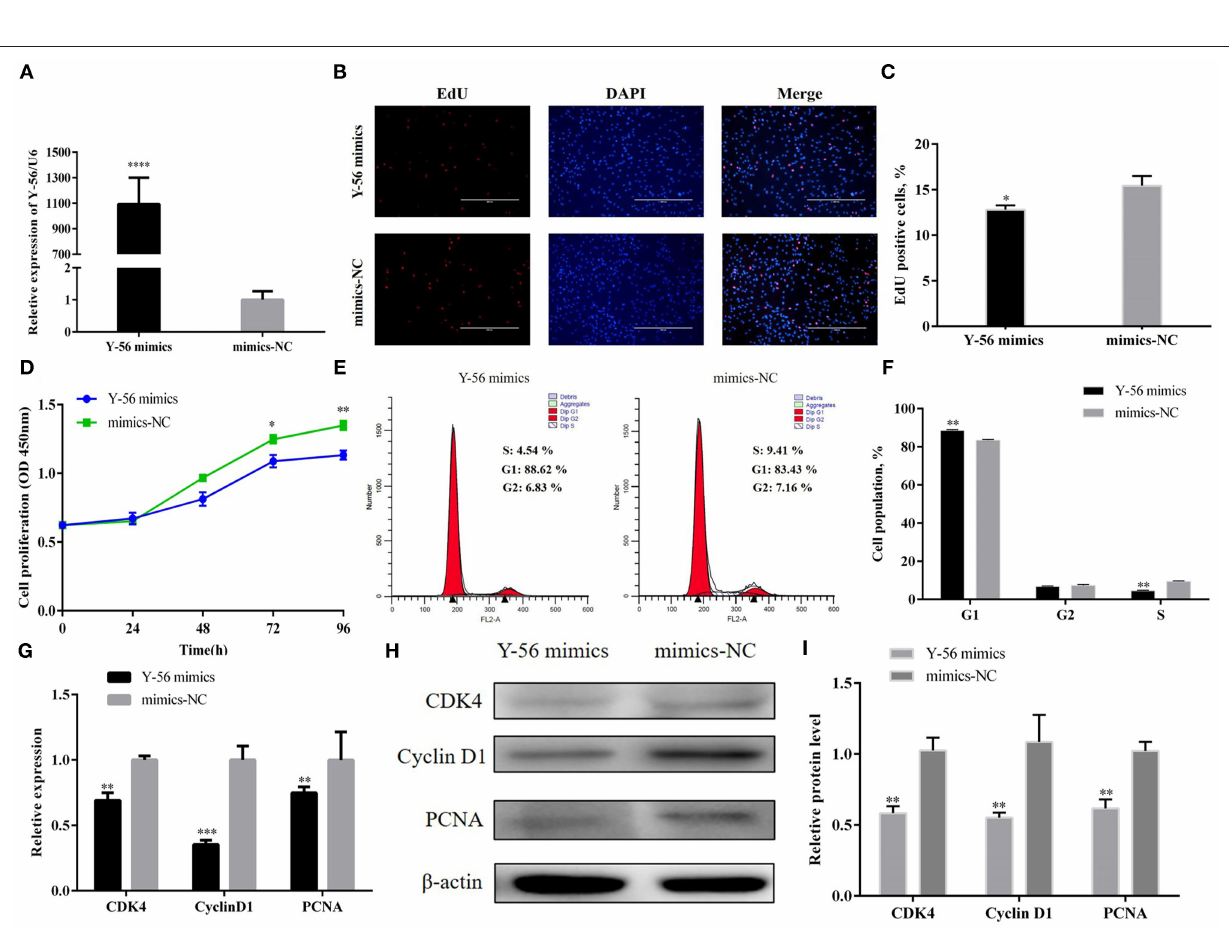
FIGURE 2 | Y-56 overexpression suppressed PSC proliferation. (A) Transfection efficiency of Y-56 mimics. (B) EdU staining after the transfection of Y-56 mimics in PSCs. (C) Statistical results of EdU staining. (D) CCK-8 assay after the transfection of Y-56 mimics into PSCs. (E) Flow cytometry raw data of the cell cycle analysis of PSCs after Y-56 overexpression. (F) Statistical results of cell cycle analysis; (G) MRNA expression levels of cell cycle marker genes. (H,I) Protein levels of cell cycle marker genes. Results are shown as mean ± SEM, and the data are representative of at least three independent assays. Independent sample t -test was used to analyze the statistical differences between groups (* P < 0.05, ** P < 0.01, *** P < 0.001, and **** P <